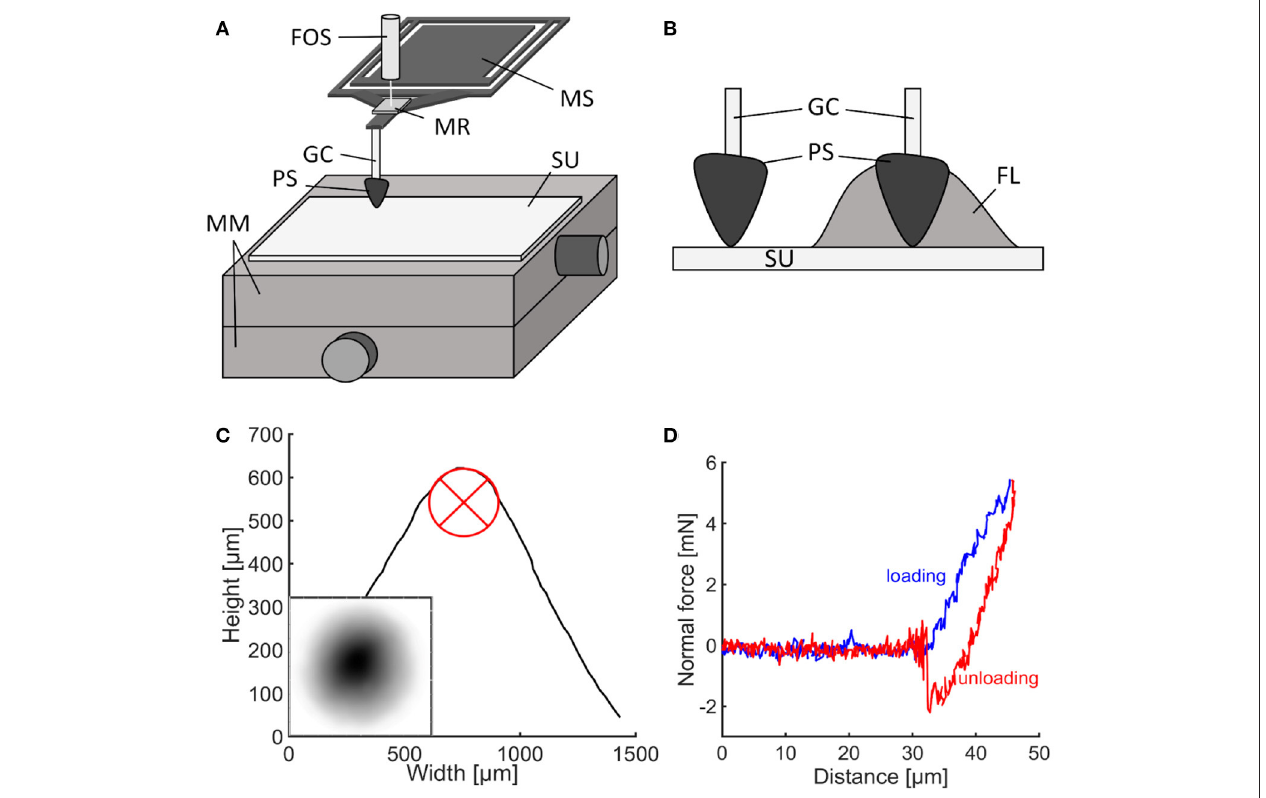
FIGURE 2 | Adhesion experiments. (A) Experimental set-up for adhesion testing with Basalt-01 mechanical tester (Tetra GmbH). (B) Propolis contact in presence of fluid and without fluid. (C) 3D-profile of the propolis sample. The circle was used to measure the tip radius. The small subimage depicts the sample’s topography, with darker areas depicted higher than lighter areas. (D) Typical force-distance curve obtained from adhesion experiments. FL, fluid droplet; FOS, fiber optical sensor; GC, glass capillary; MM, 2D-micro-manipulators; MR, mirror; MS, metal spring; PS, propolis sample; SU,